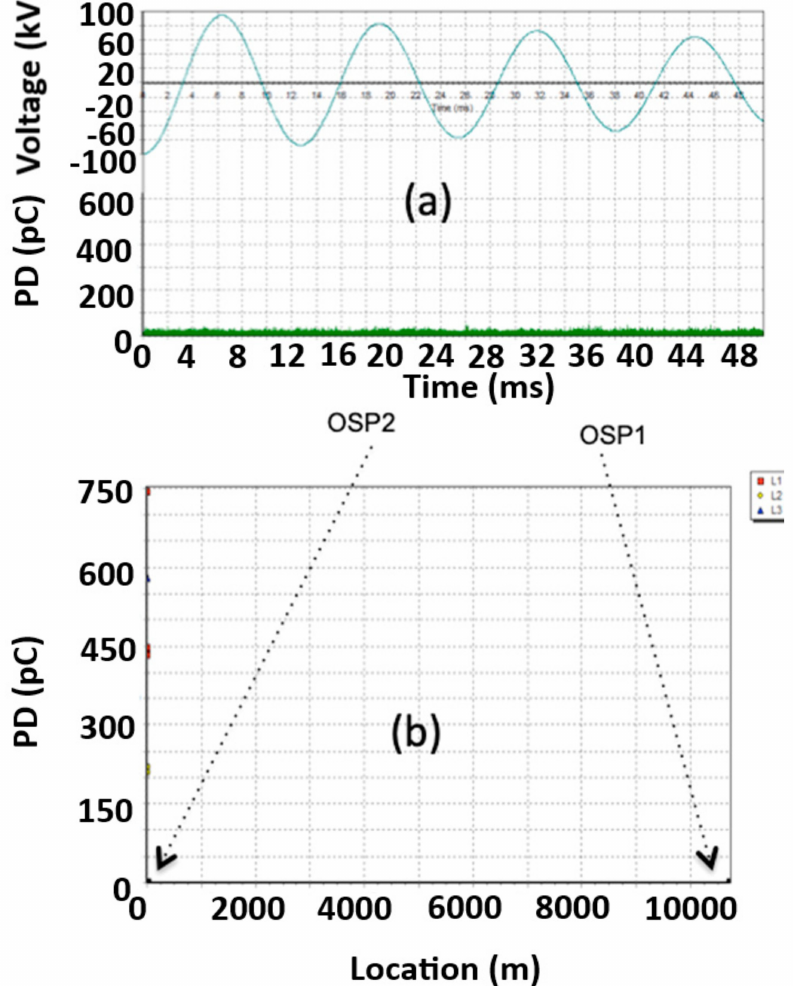
Figure 11. Onsite testing of a 66 kV 10.8 km long XLPE inter-array connector cable system: ( a ) PD pattern as observed up to 2.0 Uo test voltage ( b ) PD mapping showing that there is no PD observed above the background-noise level of 30